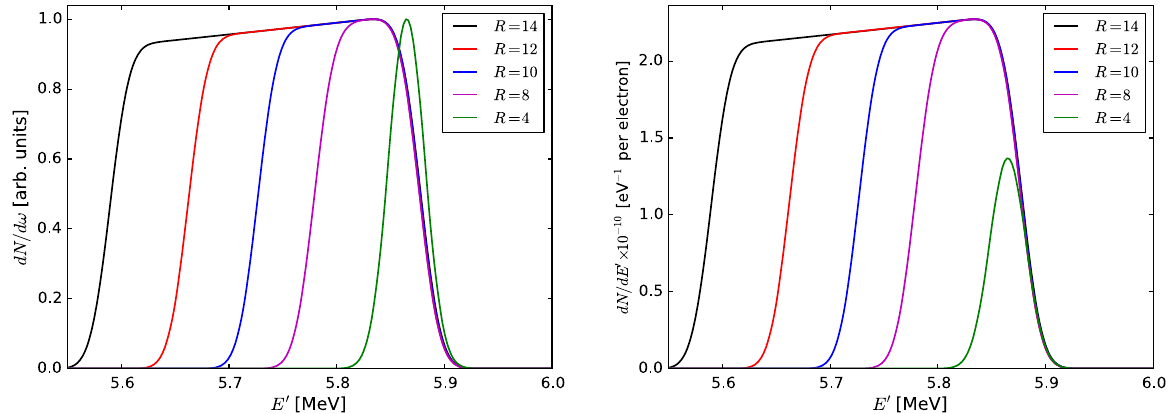
FIG. 2. The number density of the energy spectrum of a Compton gamma-ray beam produced by the head-on collision of a 500 MeV electron with a 800 nm pulsed laser beam, for different radii R of the collimation point (in mm), as in Fig. 3 in Ref. [7]. The aperture is 60 m downstream from the collision point. The horizontal emittance and energy spread of the electron beam are held constant at 0.05 nm rad and 2 × 10 − 3 , respectively. Here a Gaussian laser pulse with σ ¼ 50 is used, while the laser in Ref. [7] is CW. Each curve is generated by averaging 400 electrons sampling the prescribed distribution. Left panel: Spectra scaled to their respective peak values (compare with Fig. 3(b) of Ref. [7]). Right panel: Spectra in physical units.